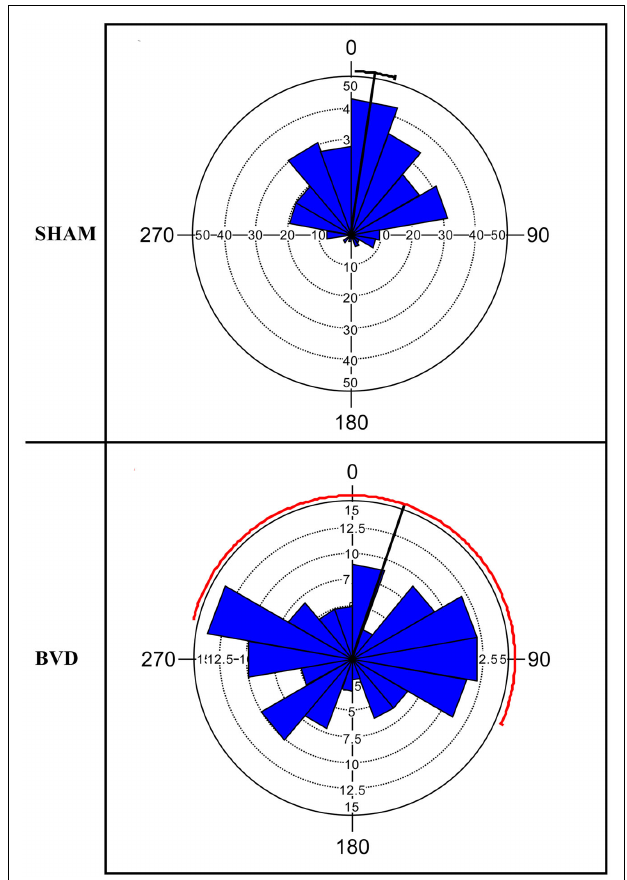
FIGURE 1 | Rose diagram showing the initial heading angles of the sham and BVD animals for the dark training at 14months post-op. The plots represent the animals’ directions on the homeward route in a foraging task in which they had to remember the location of a home base in darkness. In the plots, 0˚ represents the correct direction or heading angle. The mean vector is indicated by the black line and 95% confidence interval (CI) for the mean is indicated by the line extending either side.The 95% CI values for the BVD animals were unreliable due to low concentration of vectors, hence the red line.The inner circles (dotted line) indicate the number of observations for the given vectors (blue triangles). Notice that the BVD animals’ heading angles were distributed equally around 360˚. Reproduced from Baek et al. (2010) with